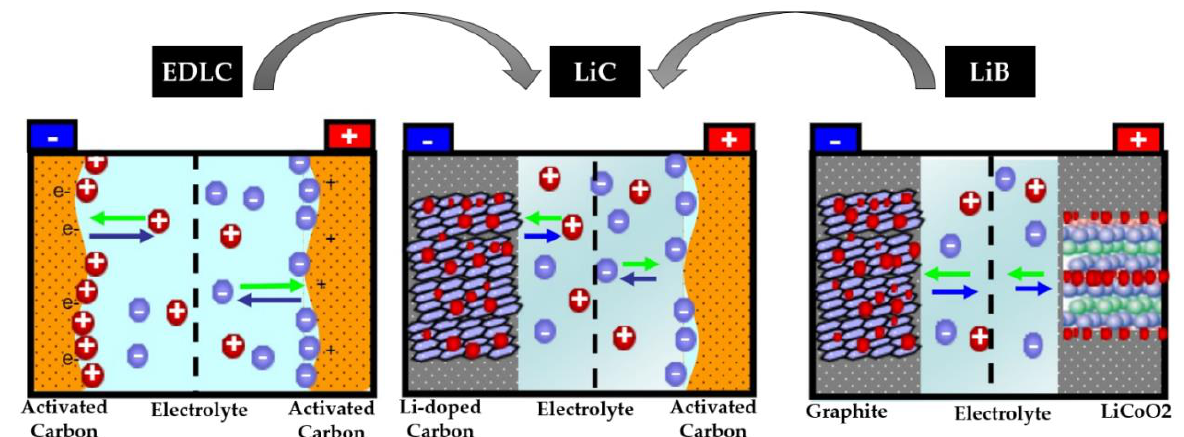
Figure 4. The storage mechanism and chemical structure of LiBs, LiCs, and EDLCs. The blue arrows denote the discharging process while the green arrows denote the charging process [25].